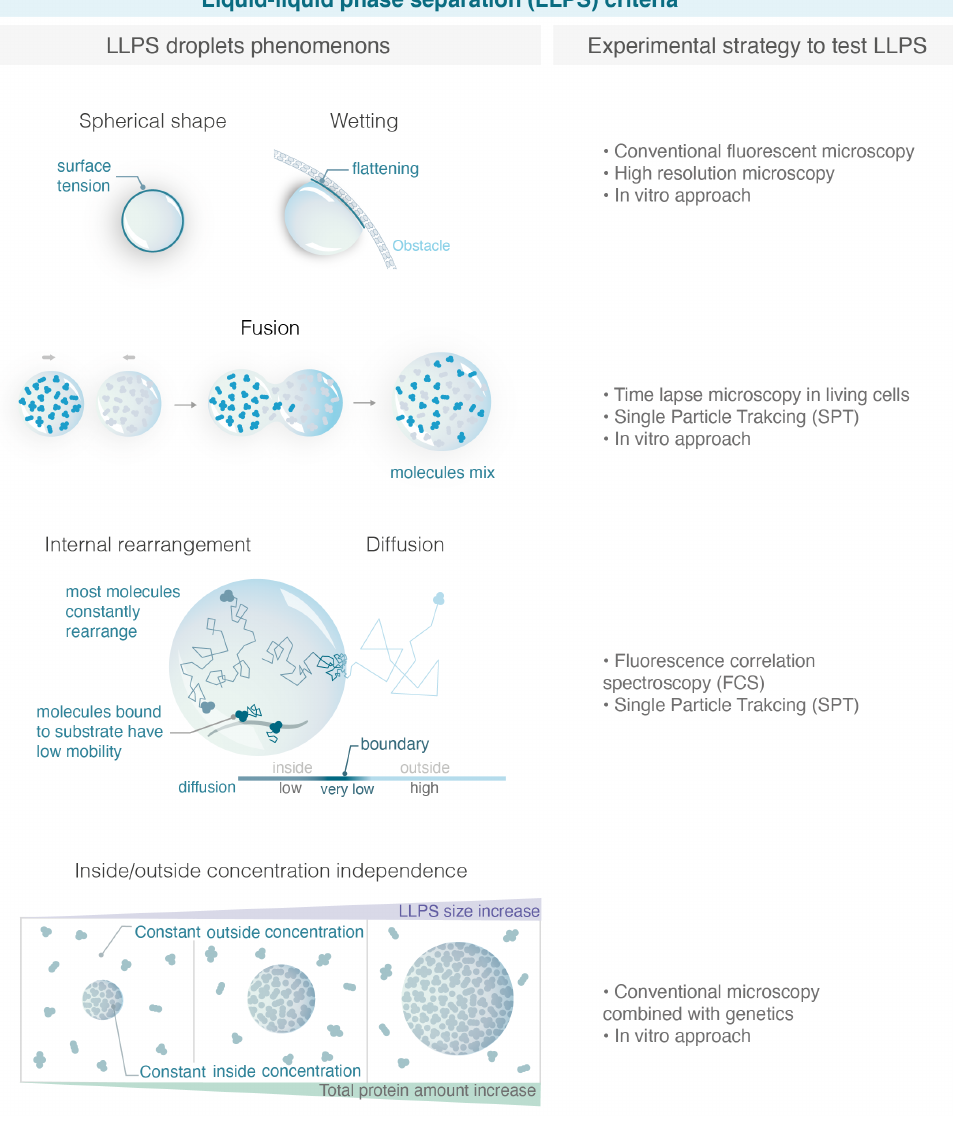
Figure 2. Criteria used to define LLPS and experimental strategies to test them. With the increase in studies claiming that condensates are liquid phase separation, it is important to define properly Figure 2. ROI extraction pipeline. robust macroscopic and microscopy experimental criteria able to distinguish LLPS from alternative models. On the left, the figure illustrates the criteria explained in the text, and on the right, the corresponding experimental strategies allowed to test them. (Illustration by Min é -Hattab and Olga